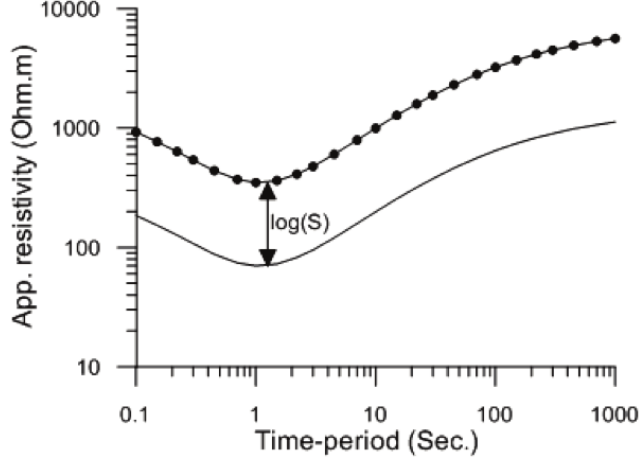
Figure 1. Example of static-shift-affected apparent resistivity